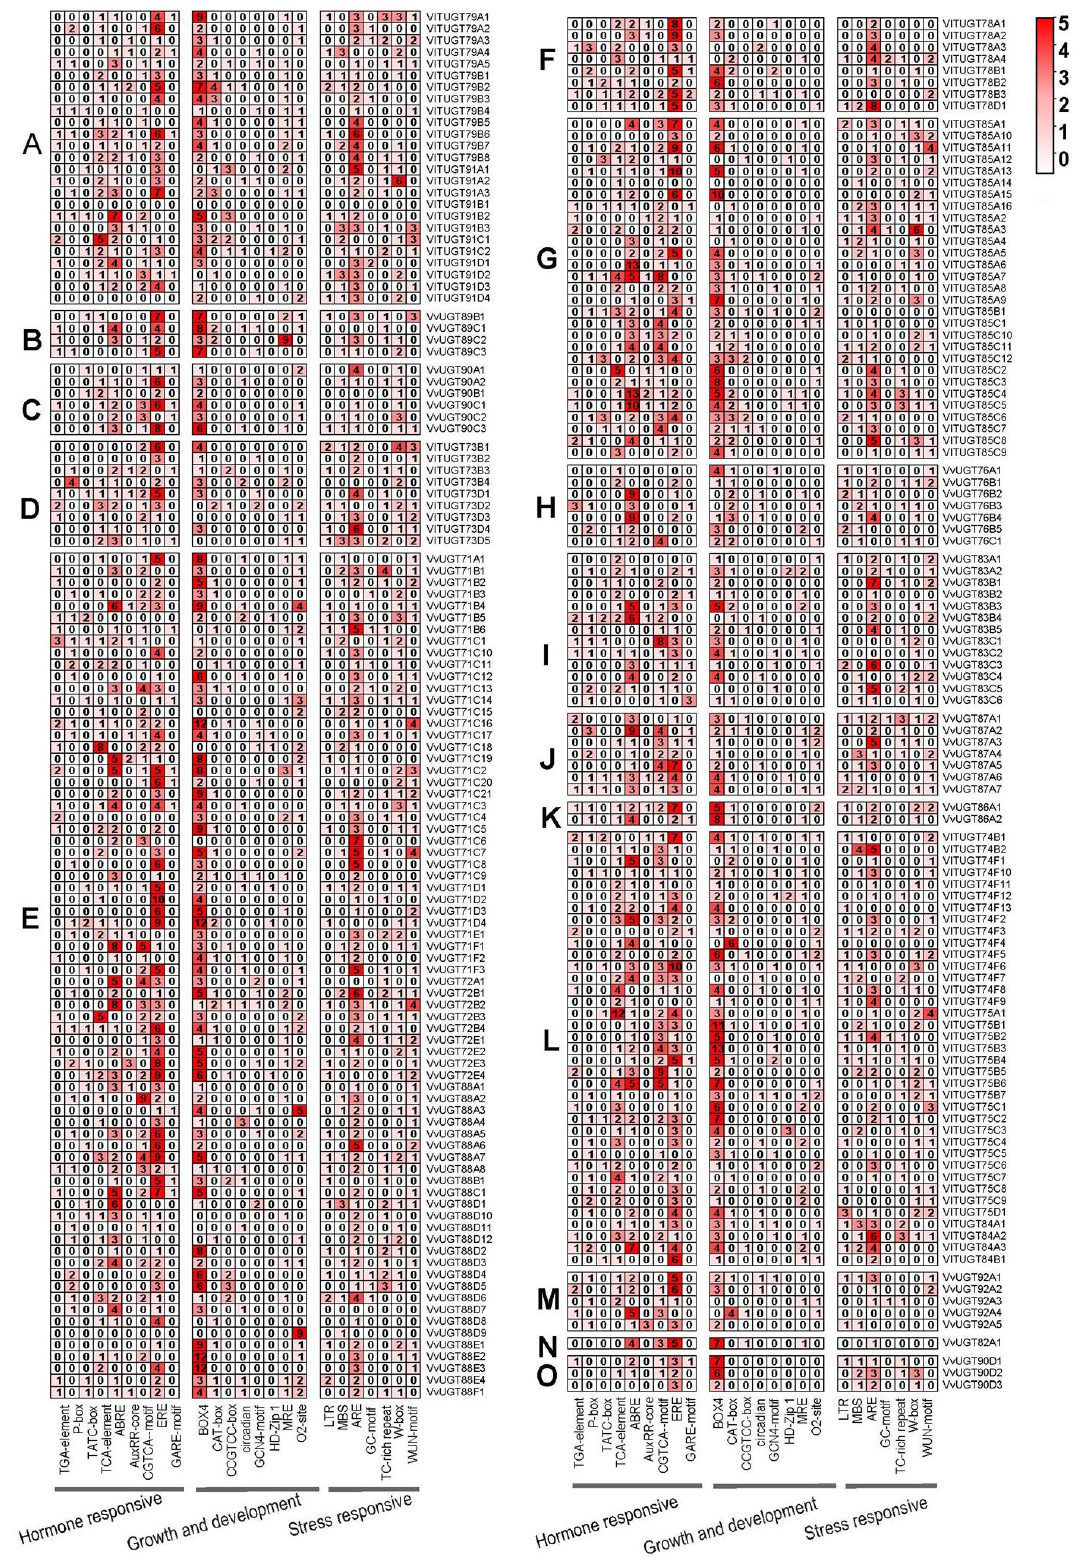
Figure 5. Predicted cis-acting elements in the promoter regions of VvUGT genes. The number inside the boxes indicates the number of cis-acting